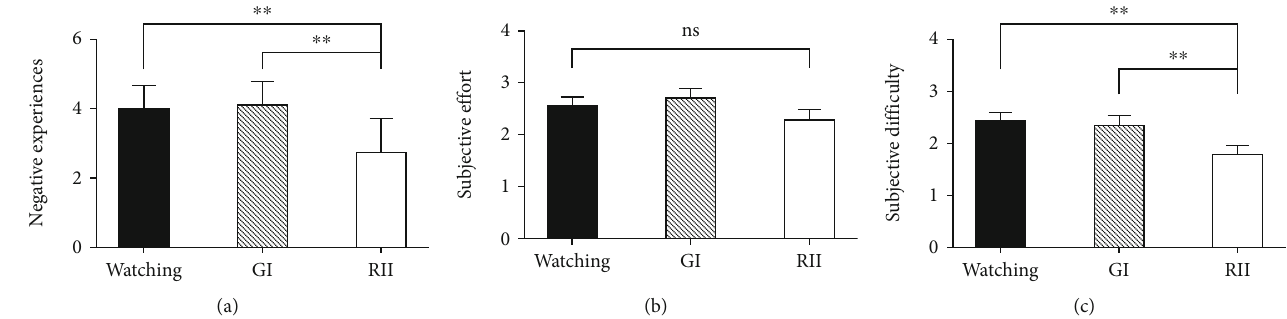
Figure 2: The subjective negative experience (a), subjective e ff ort (b), and subjective di ffi culty (c) ratings of the watching, GI, and RII conditions. Errorbars = SEM ; ∗∗ means p < 0 : 01 ; ns stands for not signi fi cant.